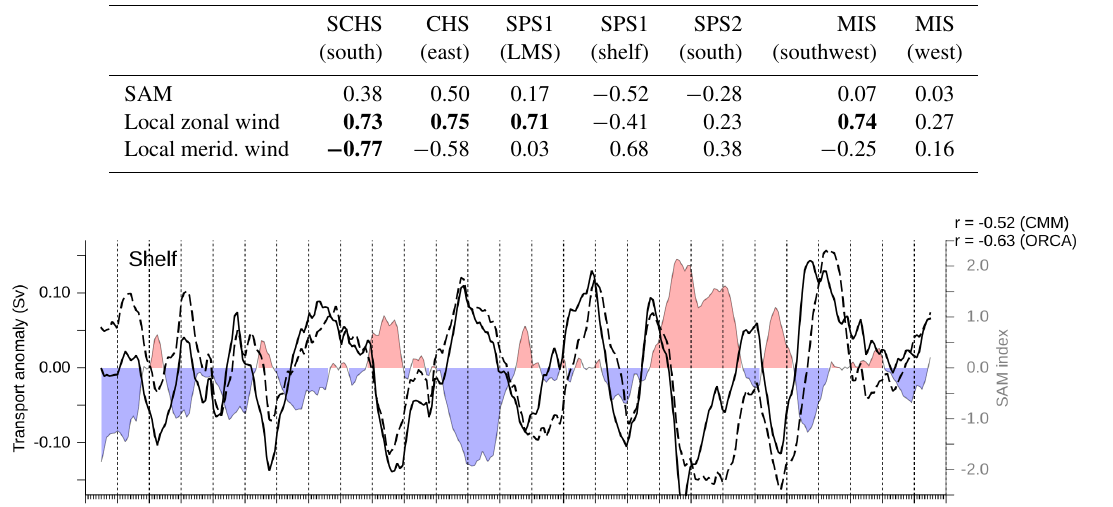
Table 2. Correlation between the SAM, local wind anomalies, and the transport anomalies across selected sections calculated from CMM: SCHS (south), CHS (east), SPS1 (LMS and shelf), SPS2 (south), and MIS (southwest and west). For each section, the local wind anomaly is calculated in the shaded regions indicated in Fig. 10. High correlations (equal to or above 0.7) are shown in bold.